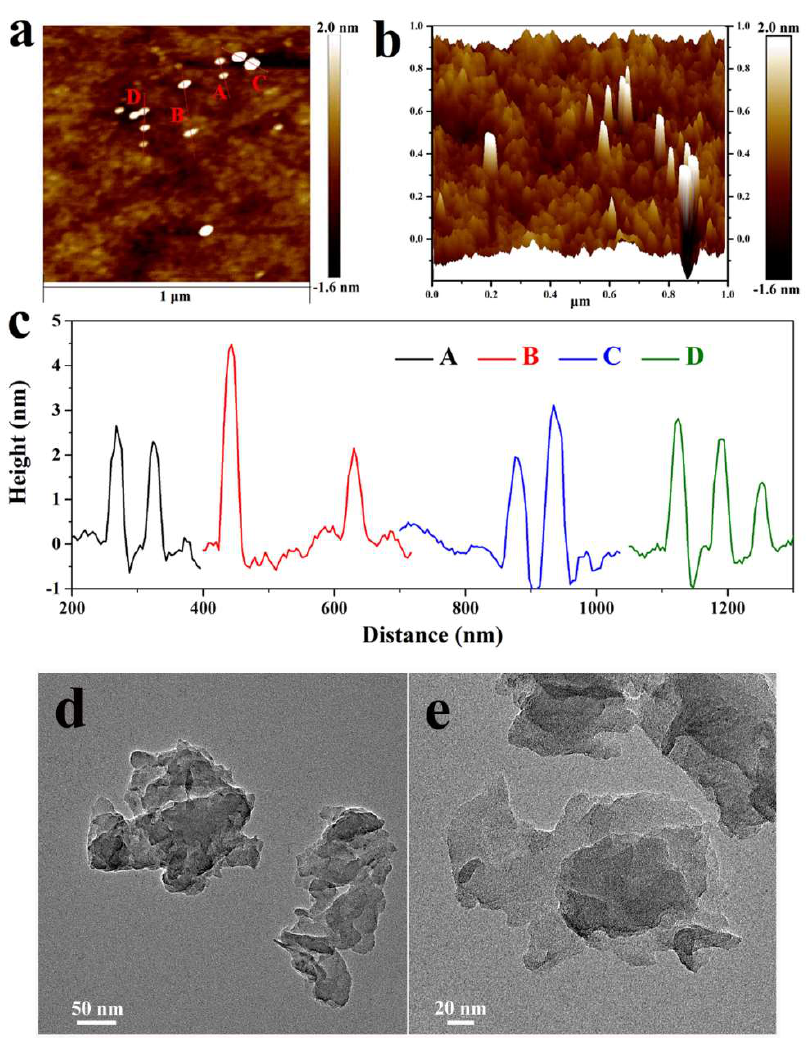
Figure 3. Atomic force microscope (AFM) ( a ) top view, ( b ) height topography image, ( c ) height trace curves of g-C 3 N 4 nanosheets placed on a silicon substrate, and ( d , e ) TEM images of g-C 3 N 4 nanosheets.